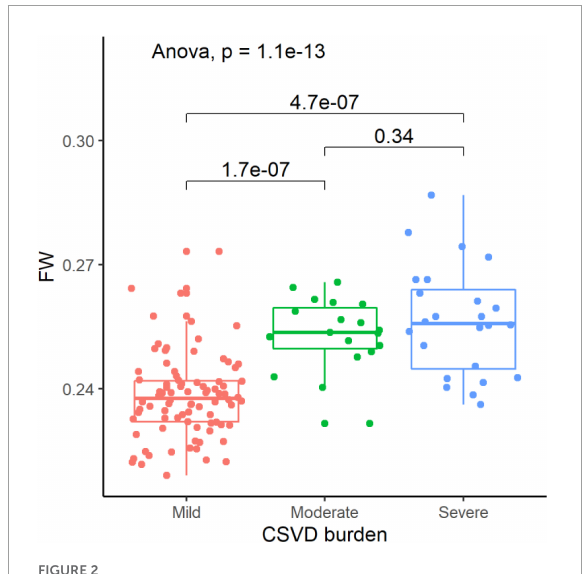
FIGURE2 Comparison of extracellular fluid volume of white matter among participants according to cerebral small vessel disease burden. FW, free water.